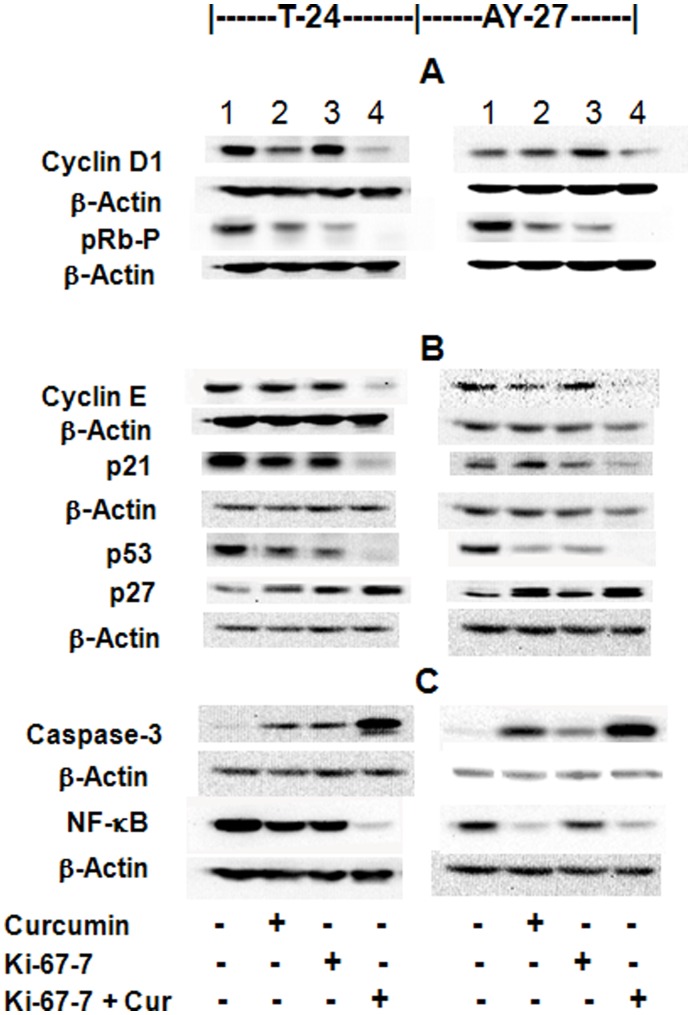
Effect of Ki-67-7 and curcumin on the regulatory proteins of cell cycle phases and apoptosis: Western blot analysis.Bladder cancer cells (T-24 and AY-27) were cultured and exposed to Ki-67-7 and curcumin as described above in legend to Figures 3A and 3B. At the end of the treatment period, total protein was extracted and subjected to Western blotting using appropriate antibodies as described in Methods. For purposes of associating proteins with specific roles, they were grouped in separate categories, such as gene transcription (A), cell-cycle progression (B) and apoptosis (C). β-actin was used as the internal control. Since different proteins (e.g. Cyclin D1 and NF-κB) from the same membrane were identified in separate categories, the same β-actin blot is displayed on more than one occasion. Data presented are western blots from a single experiment, which is representative of 2–3 identical experiments.